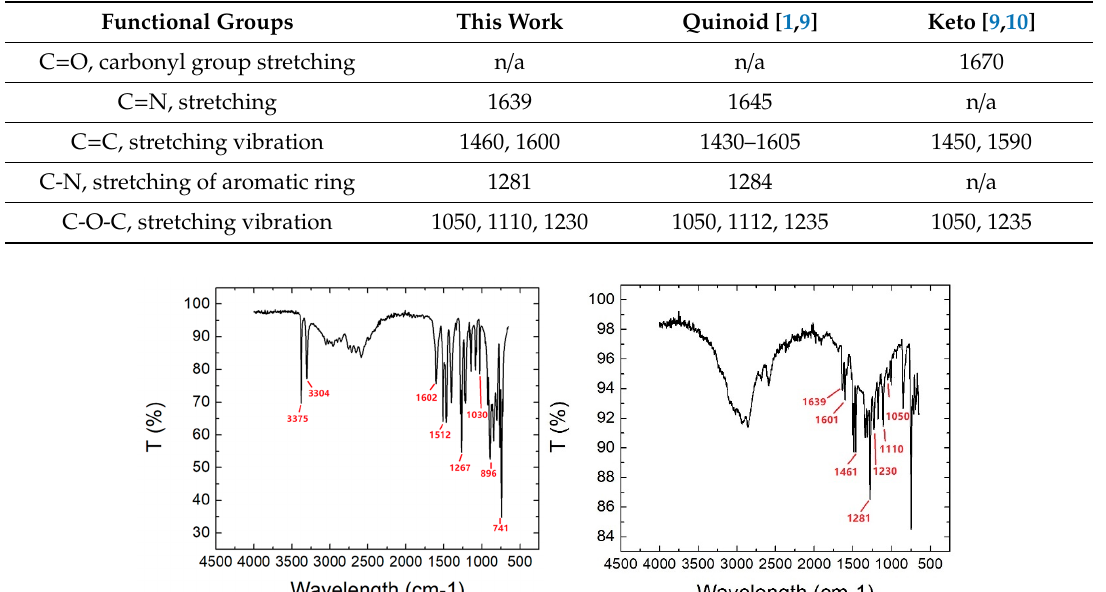
Table 1. IR peaks (unit cm − 1 ) of PoAP in literature and our present work.